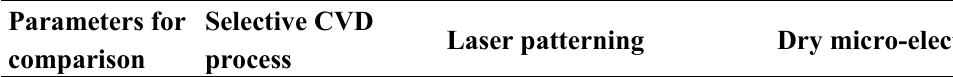
Table 2. Comparison of methods for patterning of CNT